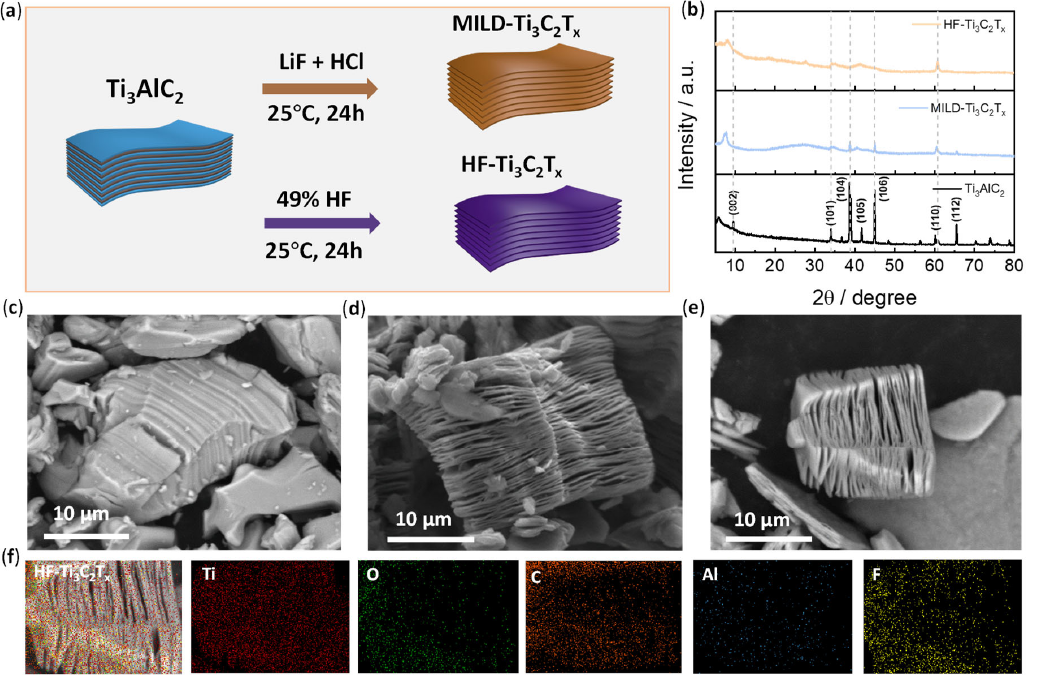
Figure 1. Preparation of Ti 3 C 2 T x and morphologies. ( a ) Schematic illustration of the synthesis of Ti 3 C 2 T x by two etching methods; ( b ) XRD patterns for the Ti 3 AlC 2 , MILD-Ti 3 C 2 T x and HF-Ti 3 C 2 T x . ( c – e ) SEM images of Ti 3 AlC 2 , MILD-Ti 3 C 2 T x and HF-Ti 3 C 2 T x . ( f ) EDS mapping analysis of HF-Ti 3 C 2 T x .